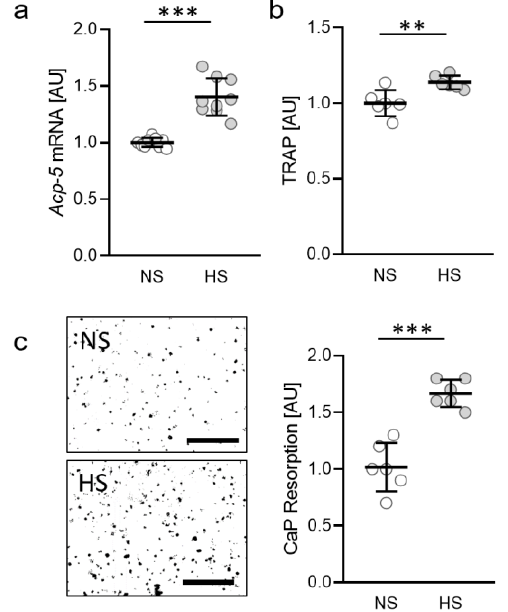
Figure 1. Gene expression of Acp-5 ( a ), release of TRAP ( b ) and CaP resorption ( c ) with normal salt (NS) and high salt treatment (HS) in murine osteoclasts differentiated from RAW264.7 macro- phages (n ≥ 6). Differentiation of osteoclasts was induced by treatment with M-CSF (30 ng/mL) and RANKL (50 ng/mL) for five days, followed by addition of 40 mM NaCl to the HS group. Sym- bols represent single data points, horizontal lines the arithmetic mean and vertical lines the stand- ard error of the mean. AU: arbitrary units. Statistics: Two-tailed unpaired t-test. ** p < 0.01; *** p < 0.001. 2.2. Impact of NaCl-Containing Diets on Expression of Genes Involved in Bone Remodelling To investigate the role of salt-containing diets on orthodontic tooth movement (OTM), we fed mice either a low salt diet (LSD), a normal salt diet (NSD) or a high salt diet and induced orthodontic tooth movement by insertion of an elastic band. First, we tested the impact of different salt contents and OTM on the expression of genes involved in bone remodeling processes. We detected no effects of OTM (LSD: p = 0.9999; NSD: p = 0.9612; HSD: p = 0.6282) on bone-mineralization-associated alkaline phosphatase ( Alpl ; Figure 2a). Different nutritional salt contents also had no effect on Alpl gene expression compared to a normal salt diet.